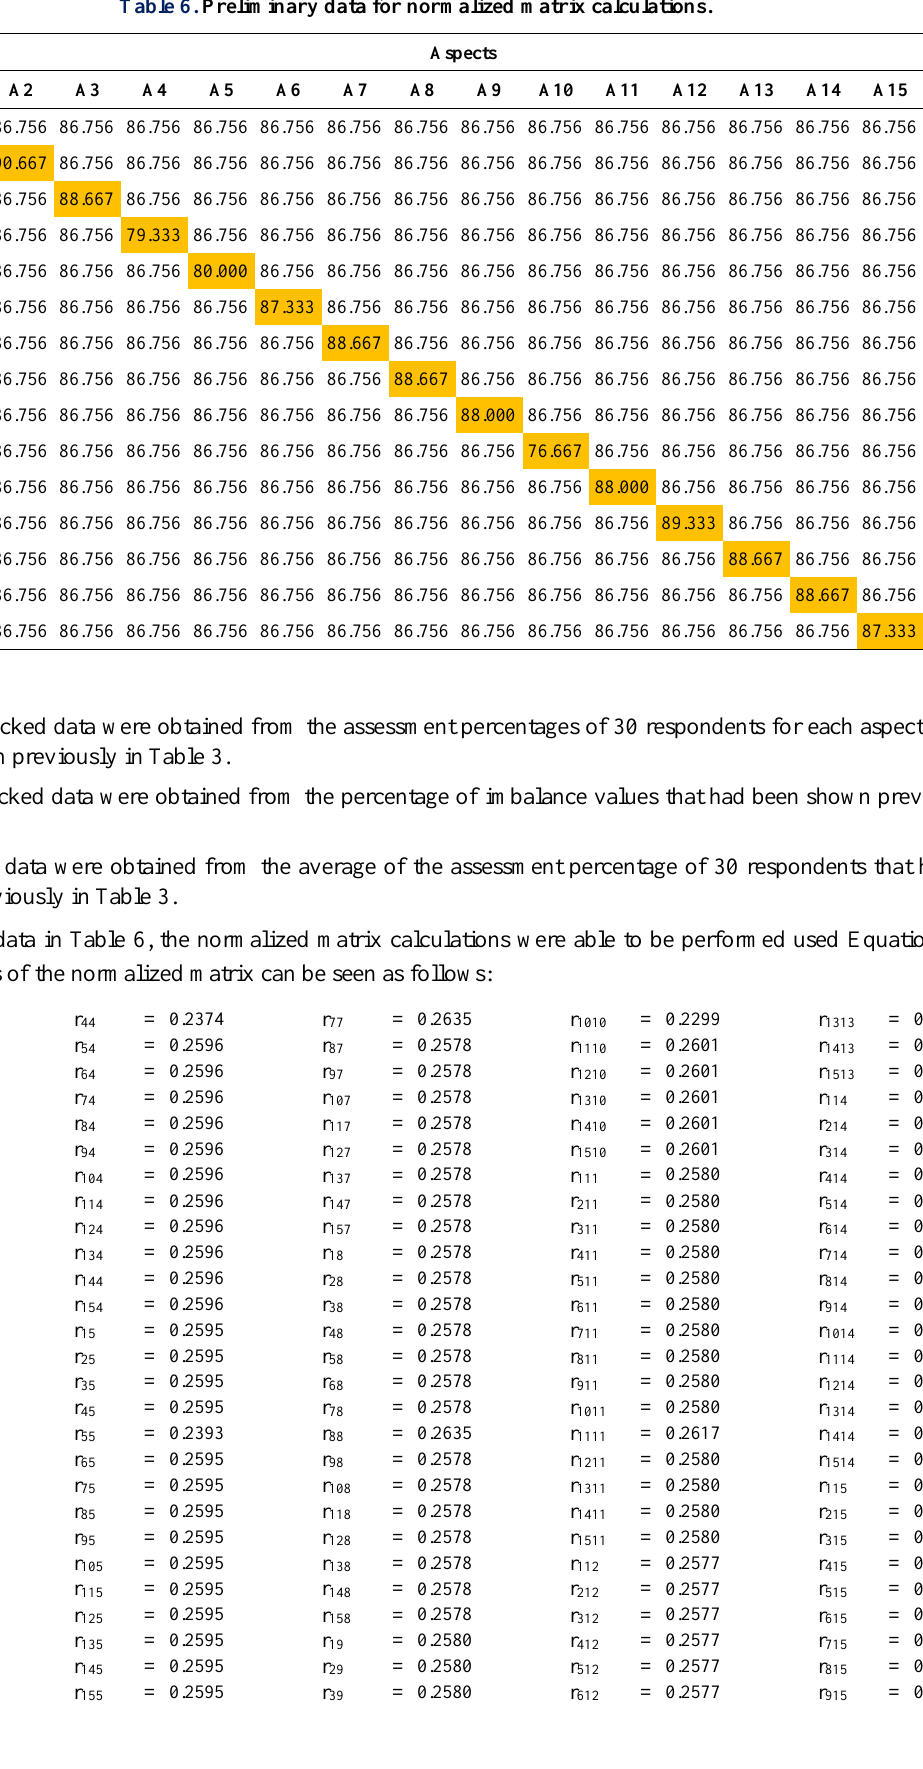
Table 6. Preliminary data for normalized matrix